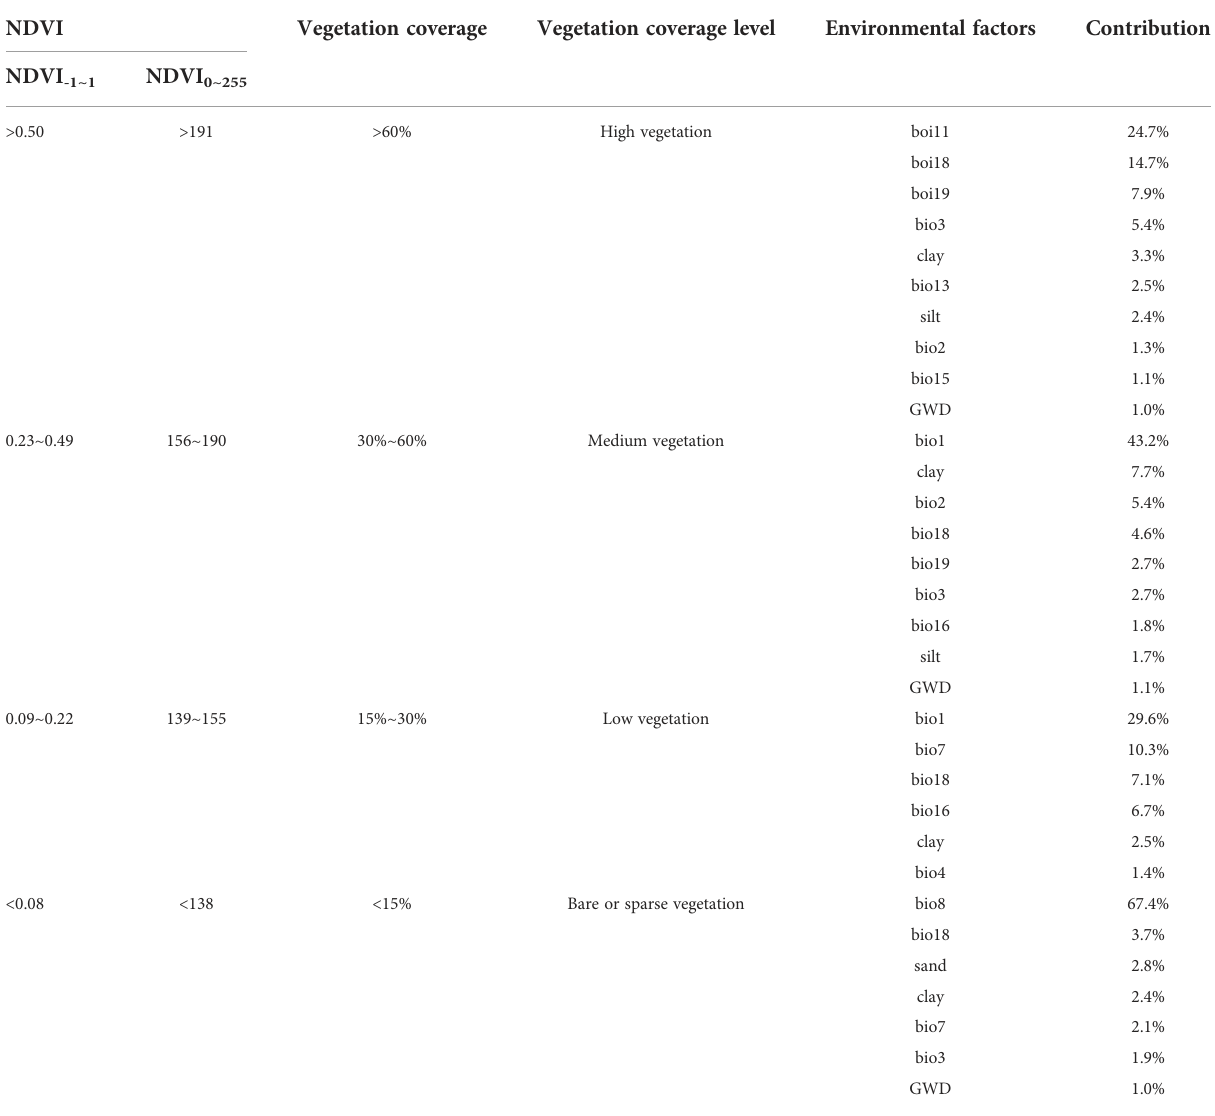
TABLE 2 The correspondence table between NDVI value and vegetation cover level.